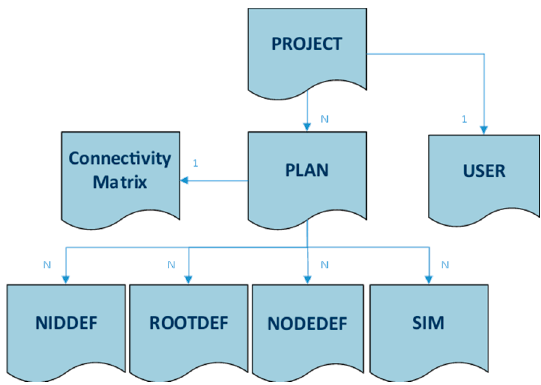
Figure 2. Diagram of the data model hierarchy and the multiplicities among its entities.